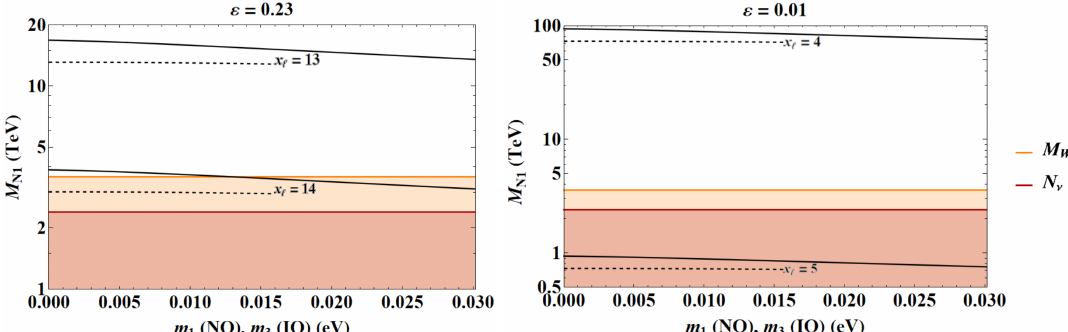
Figure 8 . Heavy neutral lepton mass M N 1 as a function of the lightest active neutrino mass, m 1 for NO and m 3 for IO, represented for several choices of the PQ charge x ‘ , and for ε = 0 . 23 and ε = 0 . 01 . The neutrino spurion satisfies | max ( Y N ) | = 1 . In the two top plots ( ε = 0 . 23 in the left and ε = 0 . 01 in the right), solid (dashed) lines indicate NO (IO): both lines are represented in the whole range available for the lightest neutrino mass. The shaded regions refer to the experimental bounds on M W and N ν as from the right plot in figure